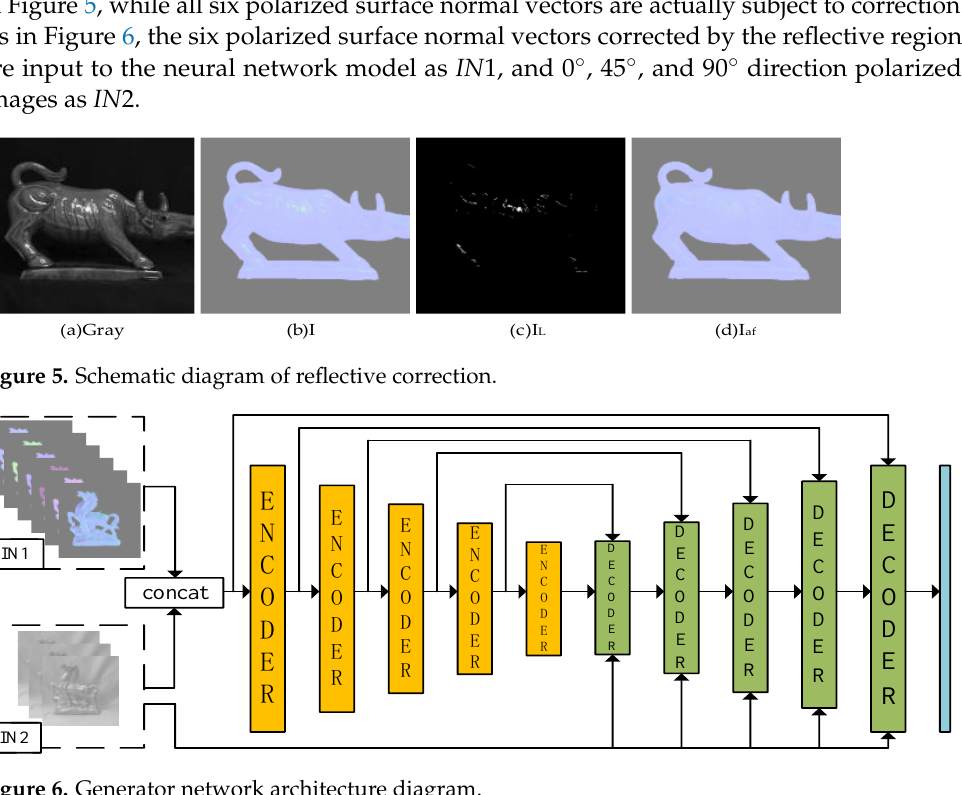
Figure 6. Generator network architecture diagram.